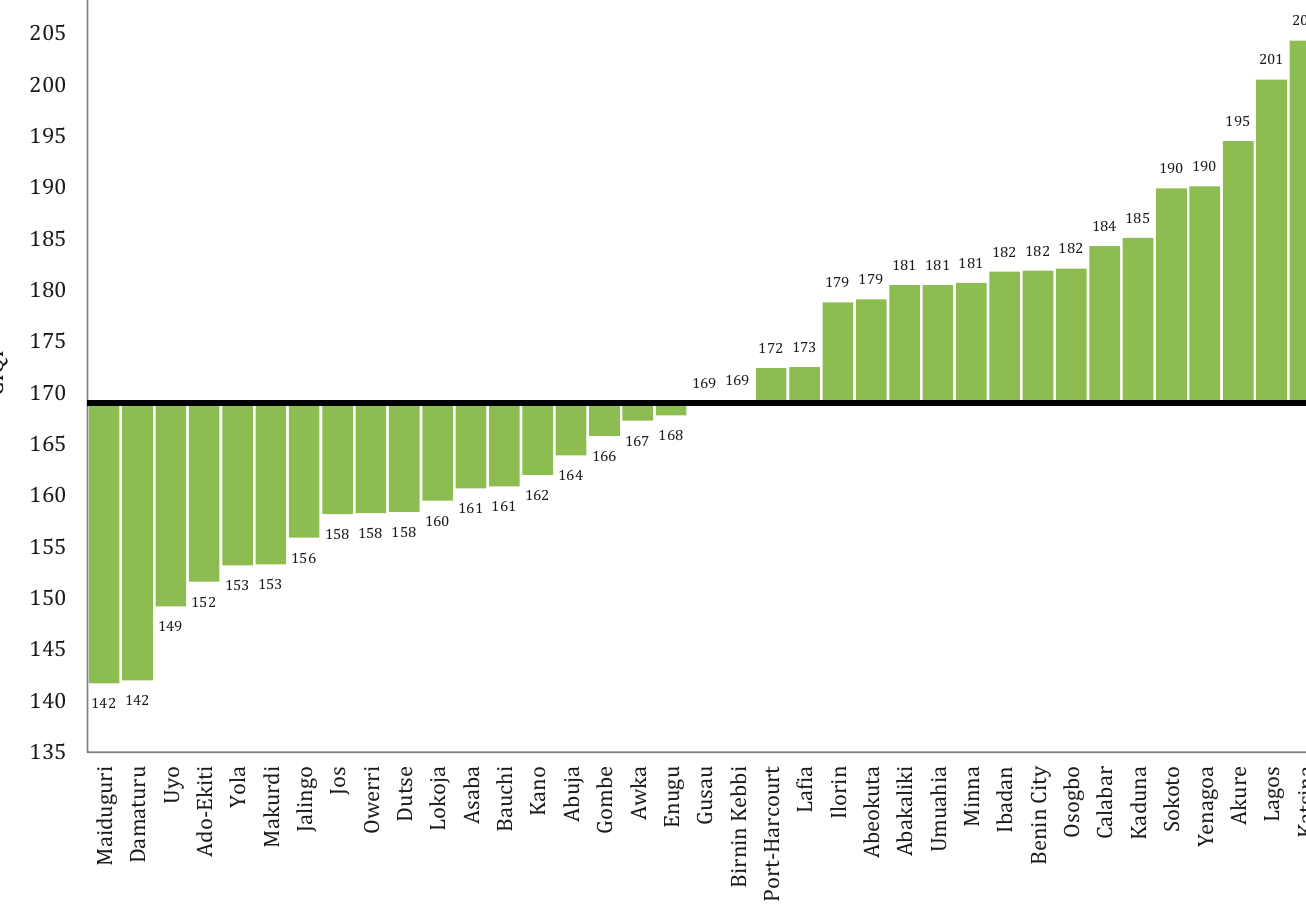
Figure 3 . Median Benchmark Analysis of the 2007/09 CIQI. Figure 3. Median Benchmark Analysis of the 2007/09